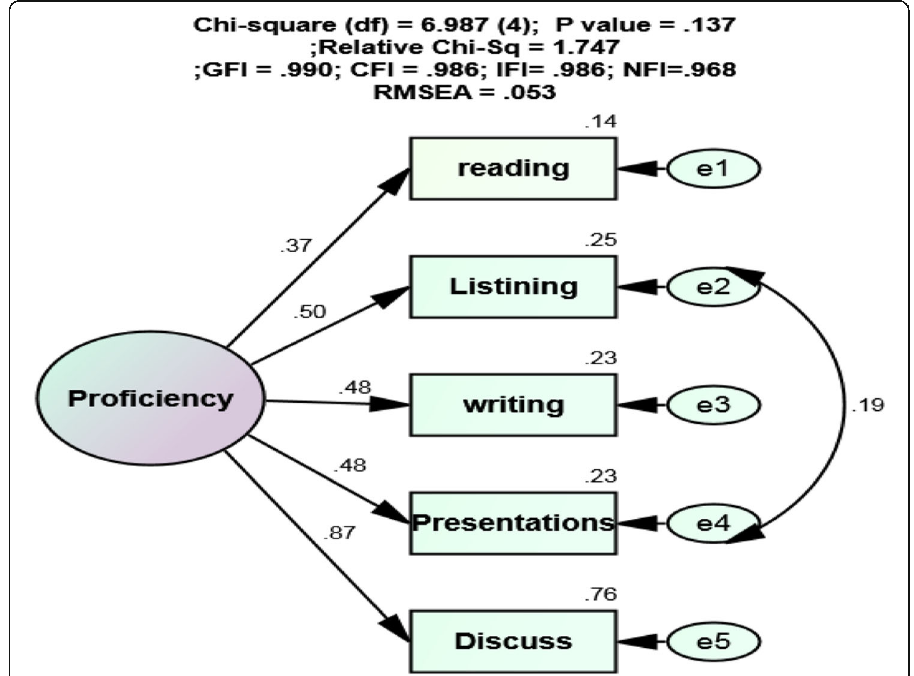
Fig. 2 The final measurement model of the dependent